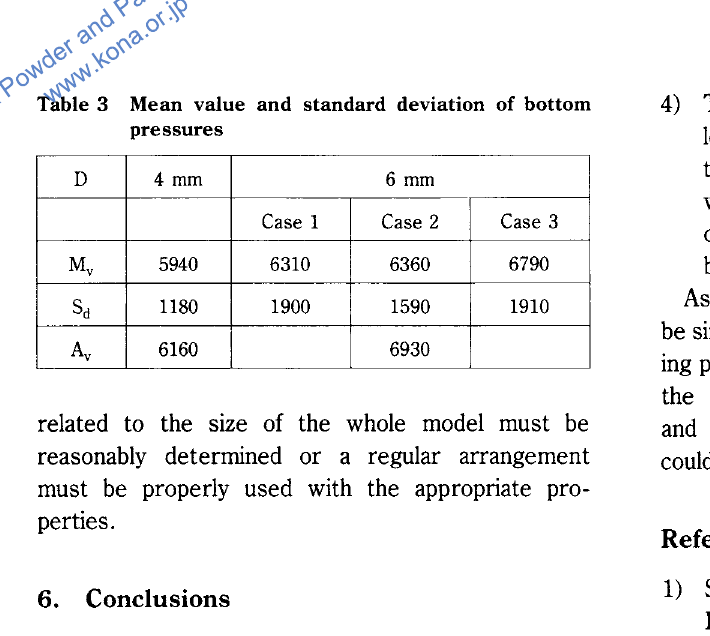
Table 3 Mean value and standard deviation of bottom